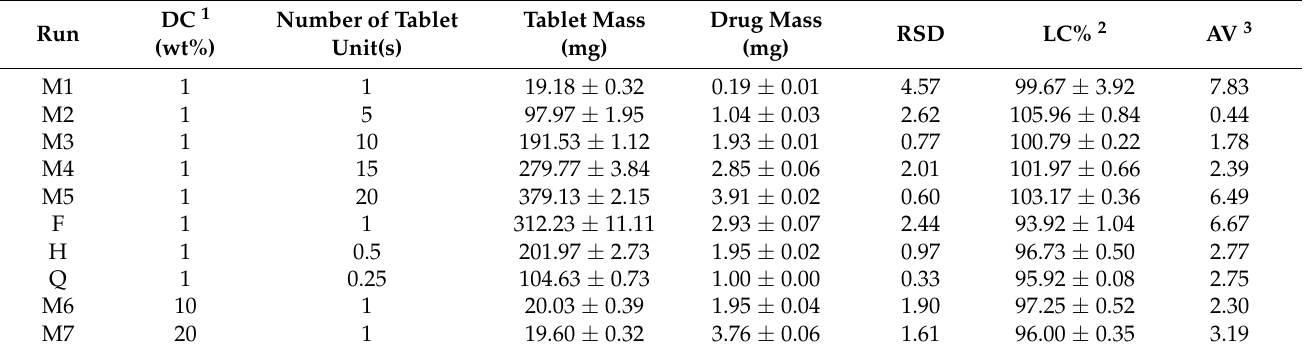
Table 3. Drug dose titration for multi-unit mini-tablets and split tablets both at 1 wt% drug concentration, and for single unit mini-tablets at 1, 10, and 20 wt% drug concentrations.